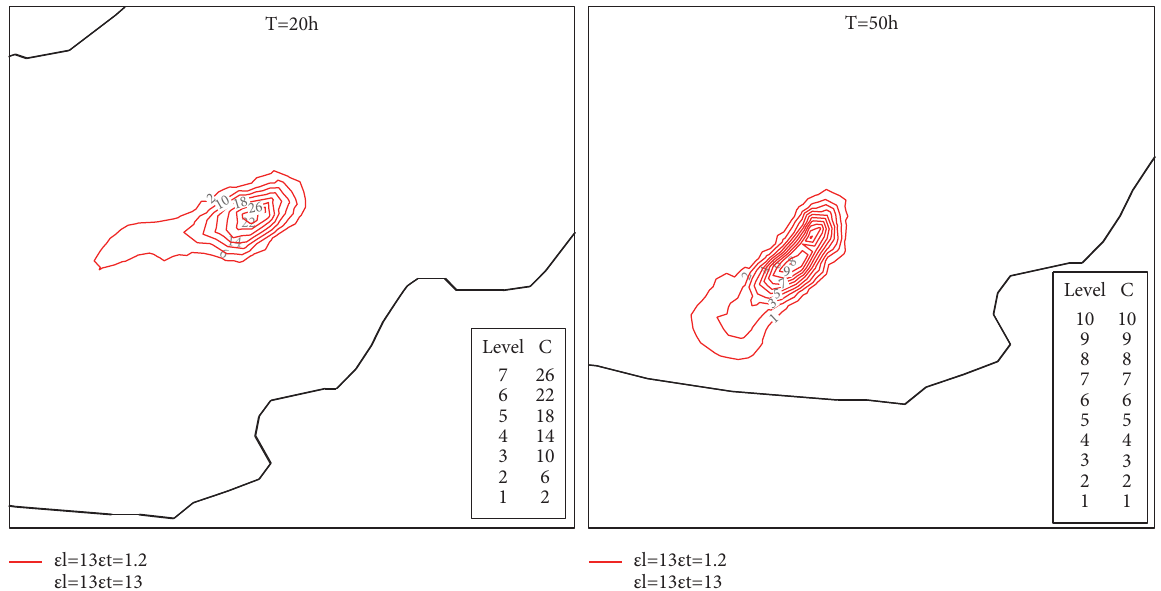
Figure 13: Comparison of the isotropic and anisotropic diffusion of pollutants with considering land-use